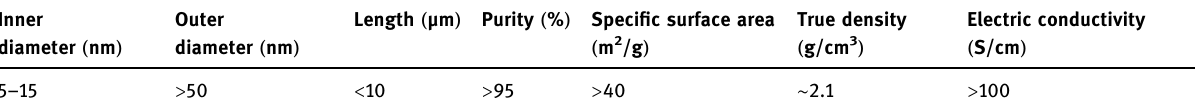
Table 2: Physical properties of multi - walled CNTs Inner